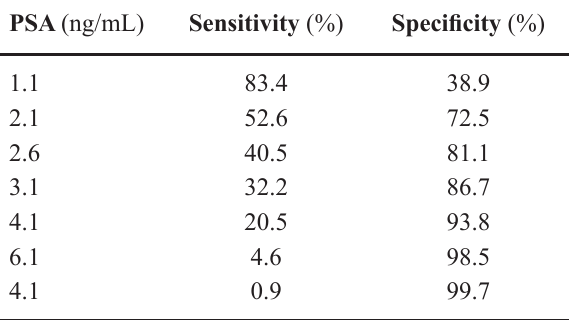
Table 1 – Sensitivity and specificity of different PSA